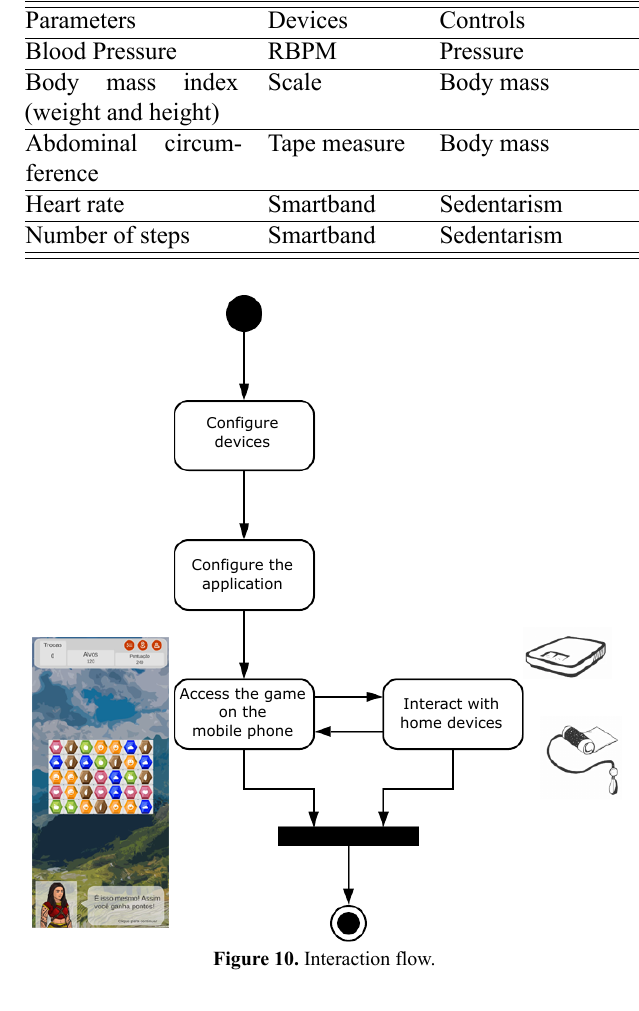
Table 3. Parameters and devices